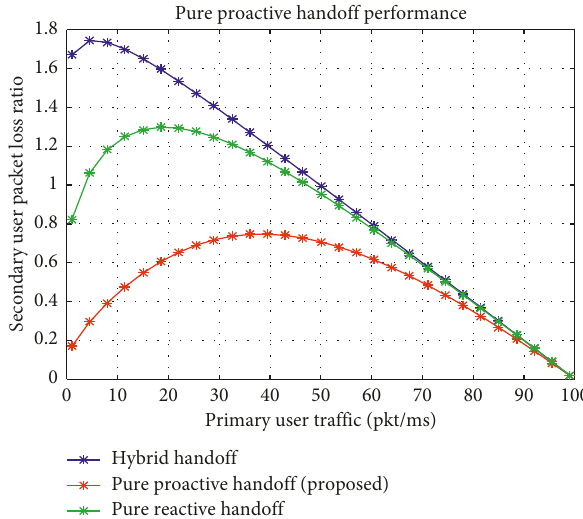
Figure 10: Performance of different spectrum handoff techniques in terms of the lost packet.